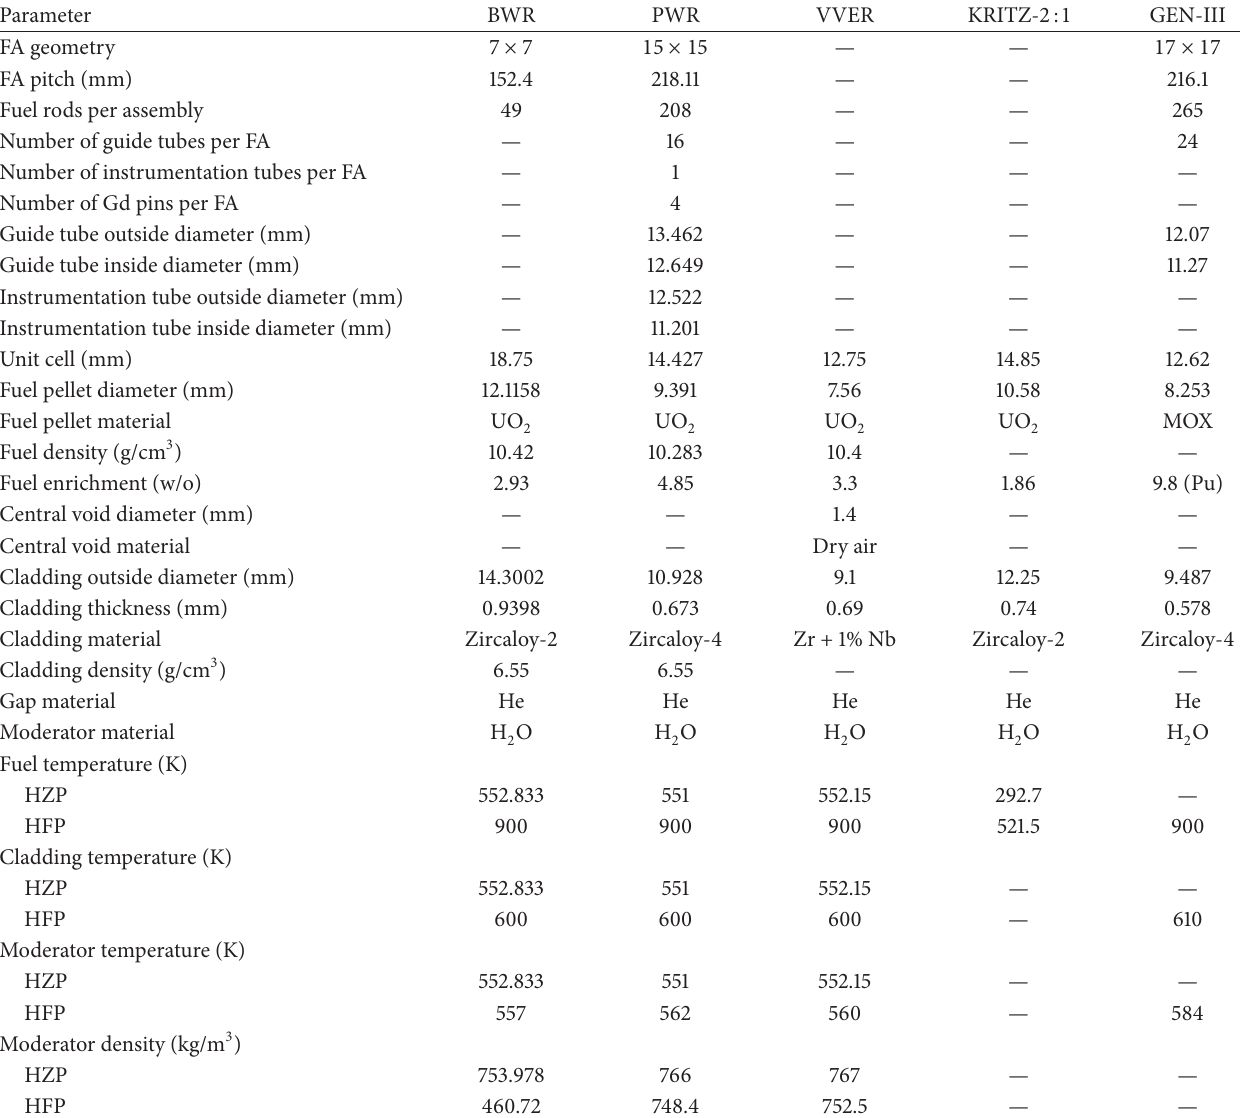
Table 1: Pin-cell data for the test cases of Exercises I-1 and Exercise